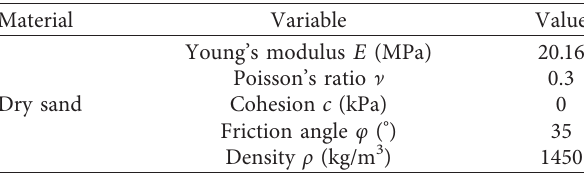
Table 1: The mechanical properties for the benchmark [38].